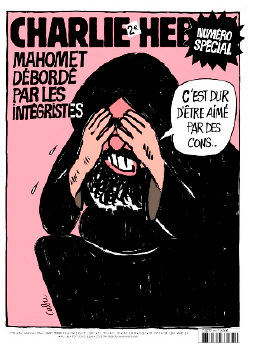
Figure 3. The Tears of the Prophet.